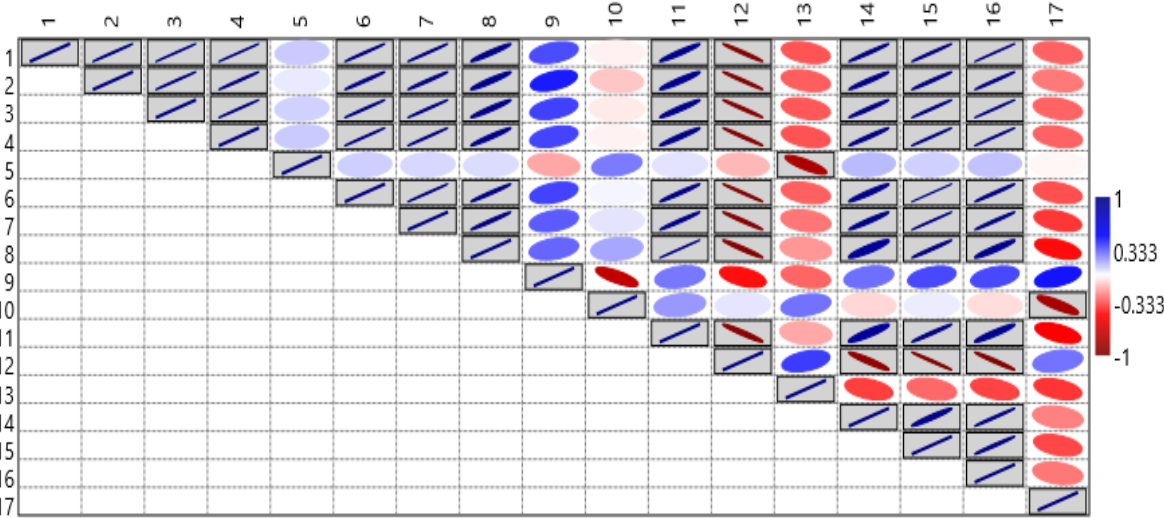
Figure 3. Pearson correlation among the bioactive compounds of Tea “Compagnia del Lago” (TCL) and Tea “Camelia d’Oro” (TCO). Boxed ellipses are significantly correlated ( p < 0.05). Blue indicates positive correlation and red indicates negative correlation. The more the ellipse is compressed, the stronger the correlation. 1. Polyphenols; 2. FRAP; 3. DPPH; 4. ABTS; 5. caffeic acid; 6. chlorogenic acid; 7. coumaric acid; 8. ferulic acid; 9. hyperoside; 10. isoquercitrin; 11. quercetin; 12. quercitrin; 13. rutin; 14. ellagic acid; 15. gallic acid; 16. catechin; 17. epicatechin.